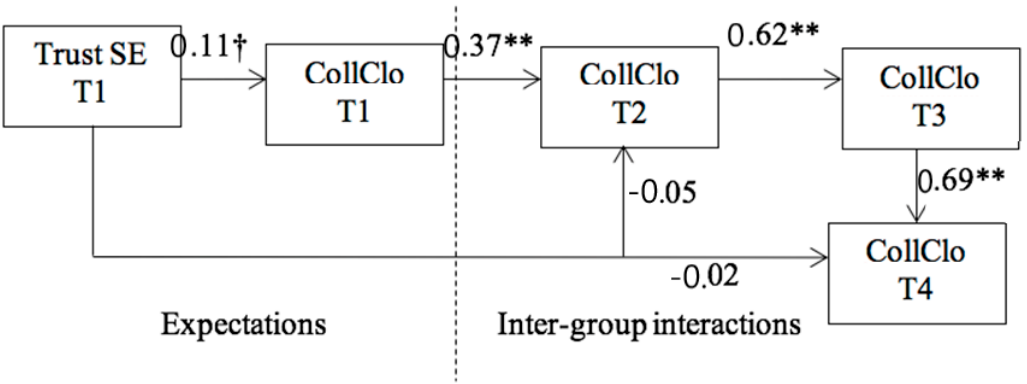
Figure 2. Results of the sequential mediation model for collaboration closeness.